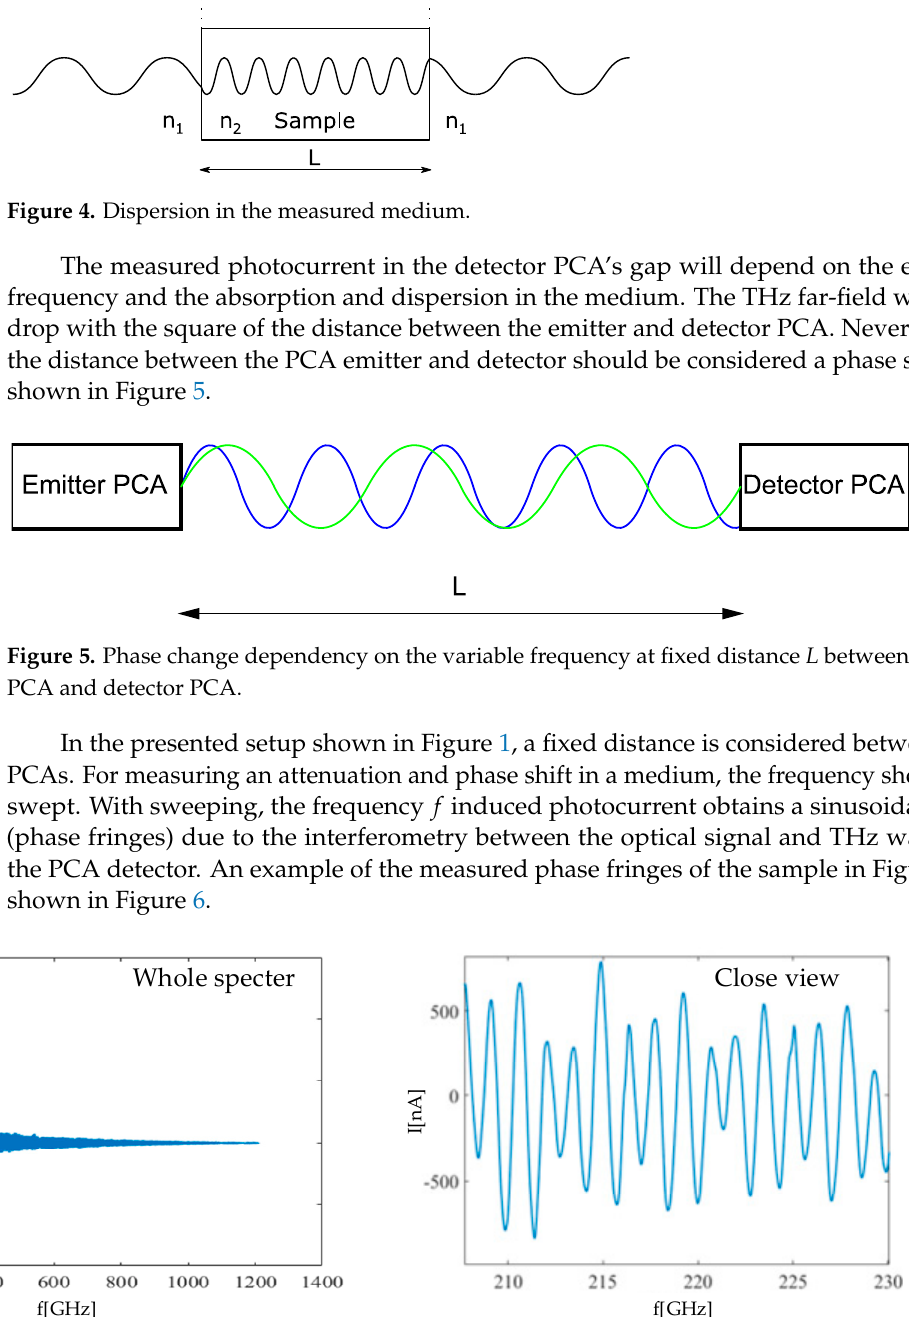
Figure 6. THz frequency sweep-phase fringes.